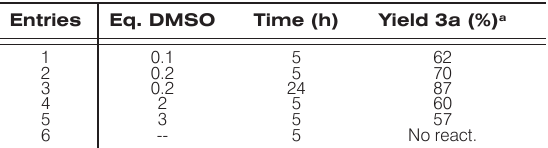
Scheme 1. Allylation of benzaldehyde in the presence of DMSO Table 1. Allylation of benzaldehyde 1a under different reaction